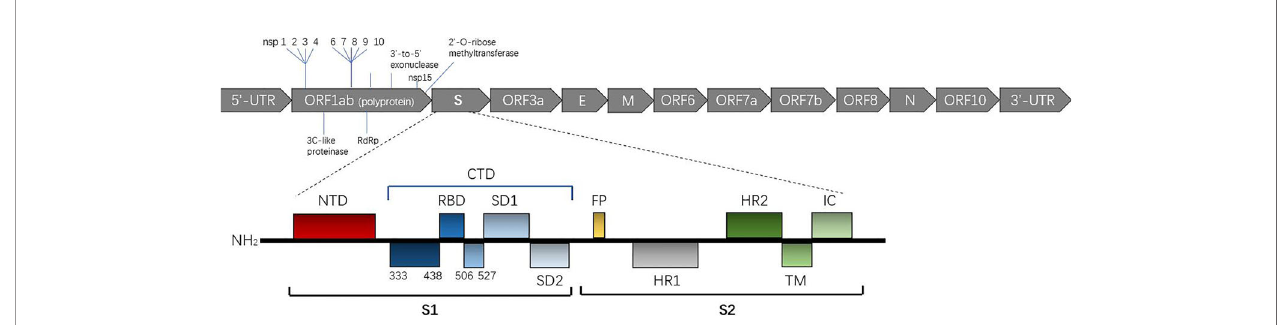
FIGURE 1 | Overall topology of the SARS-CoV-2 spike monomer. The secondary structure of the spike monomer contains two parts, S1 and S2. S1 is composed of an NTD (shown in black) and CTD (shown in blue) containing the receptor binding domain (RBD) necessary for hACE2 binding. (Expasy Reference Sequence: P0DTC2).